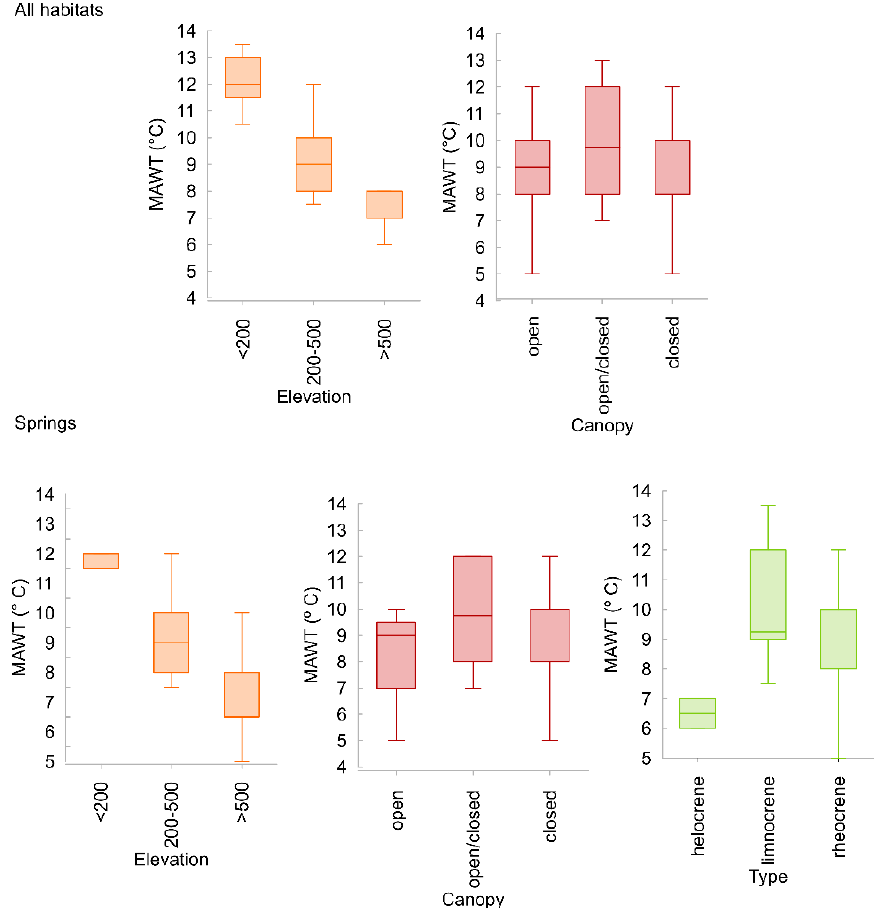
Figure 6. Differences in mean annual water temperature (MAWT) at sampled sites due to elevation, canopy cover and habitat type.